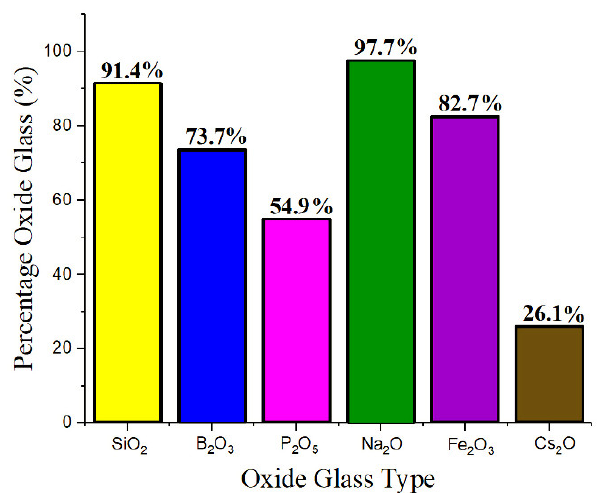
Figure 2. Percentage of occurrence of the main oxide glass formers and modifiers considering any percentage percentage content.